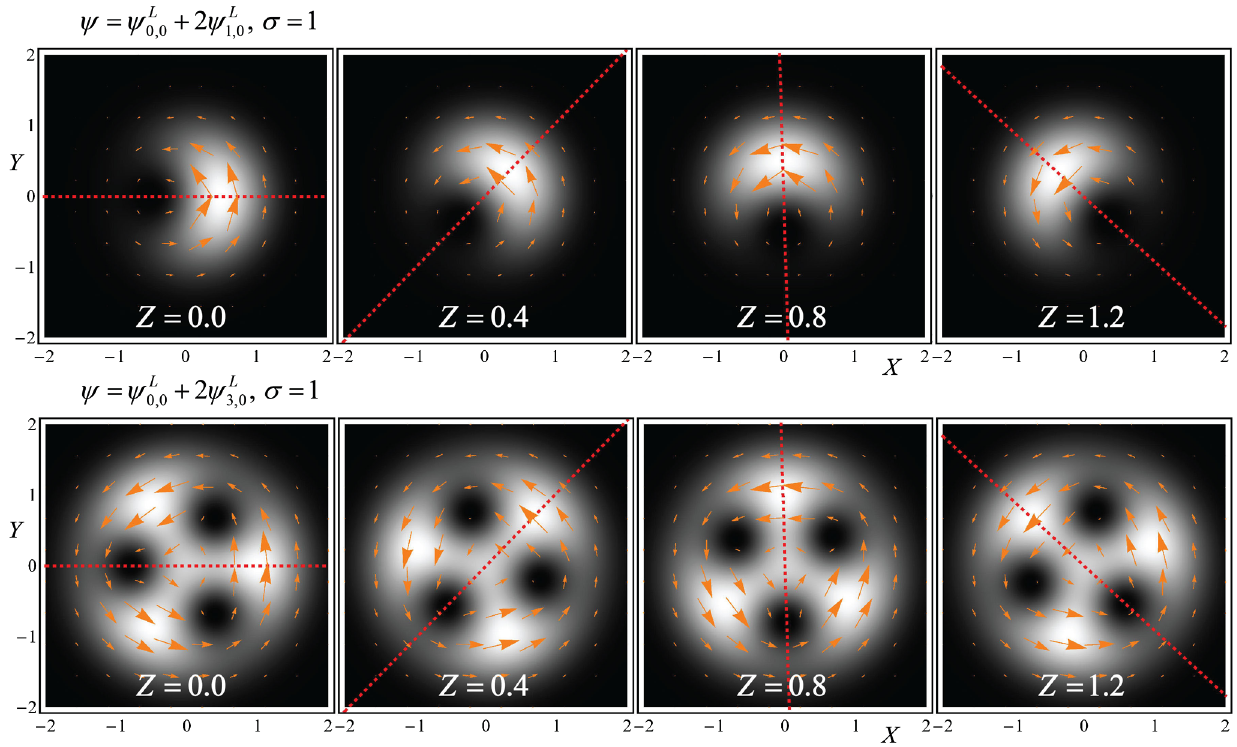
FIG. 7. Evolution of the superpositions (40) with a ¼ 2 , ‘ ¼ 1 (upper panels) and ‘ ¼ 3 (lower panels) in the magnetic field with (cid:8) ¼ 1 . Probability densities and currents are shown. The rotation on propagation along z , Eq. (41a), corresponds to the double-Larmor ¼ 2 j (cid:2) j . The double rotation is caused by the addition of the transverse-current contributions from the (i.e., cyclotron) frequency ! c (see Fig. 9). The dimensionless coordinates X ¼ x=w vortex exp ð i‘’ Þ and from the vector-potential A ’ are